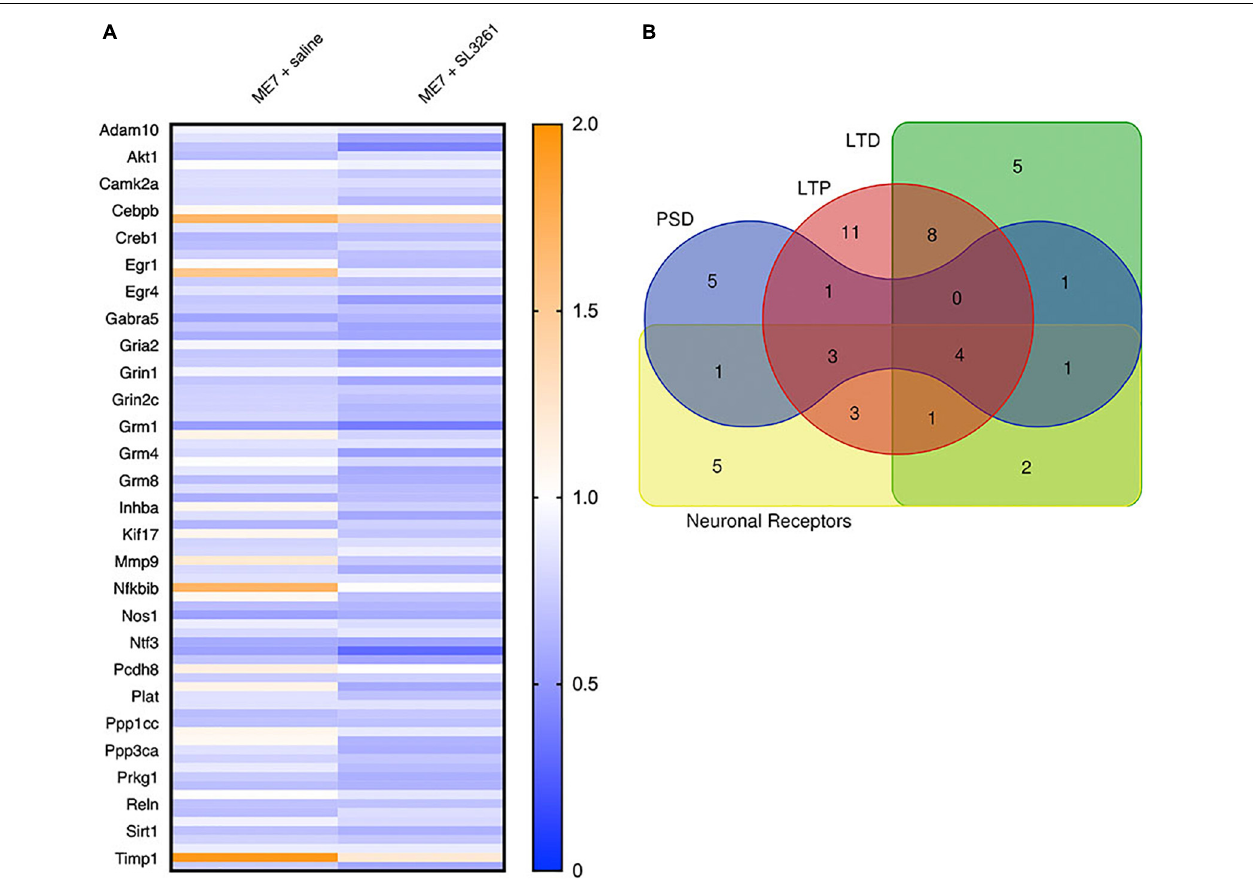
FIGURE 4 | Heatmap and gene associations. Analysis of synaptic plasticity genes in ME7 prion mice at 12-wpi following infection with S. typhimurium SL3261 . (A) Expression of 84 genes with functions linked to synaptic plasticity, including genes associated with long-term potentiation (LTP), long-term depression (LTD), the post-synaptic density (PSD) and neuronal receptors. (B) Overlap of genes associated with specific functions in synaptic